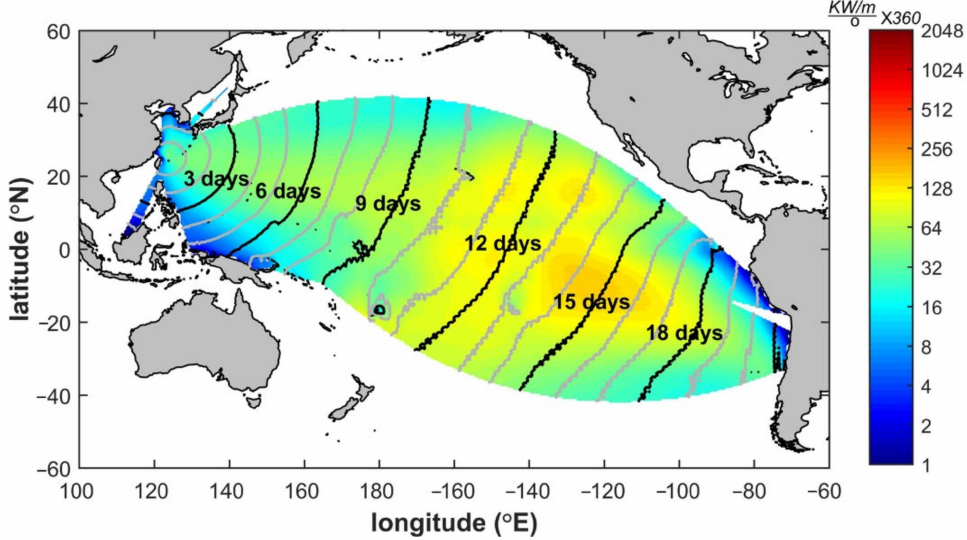
Figure 3. Mean effective energy flux obtained using ESTELA method from 1980 to 2004 in the east of Taiwan.